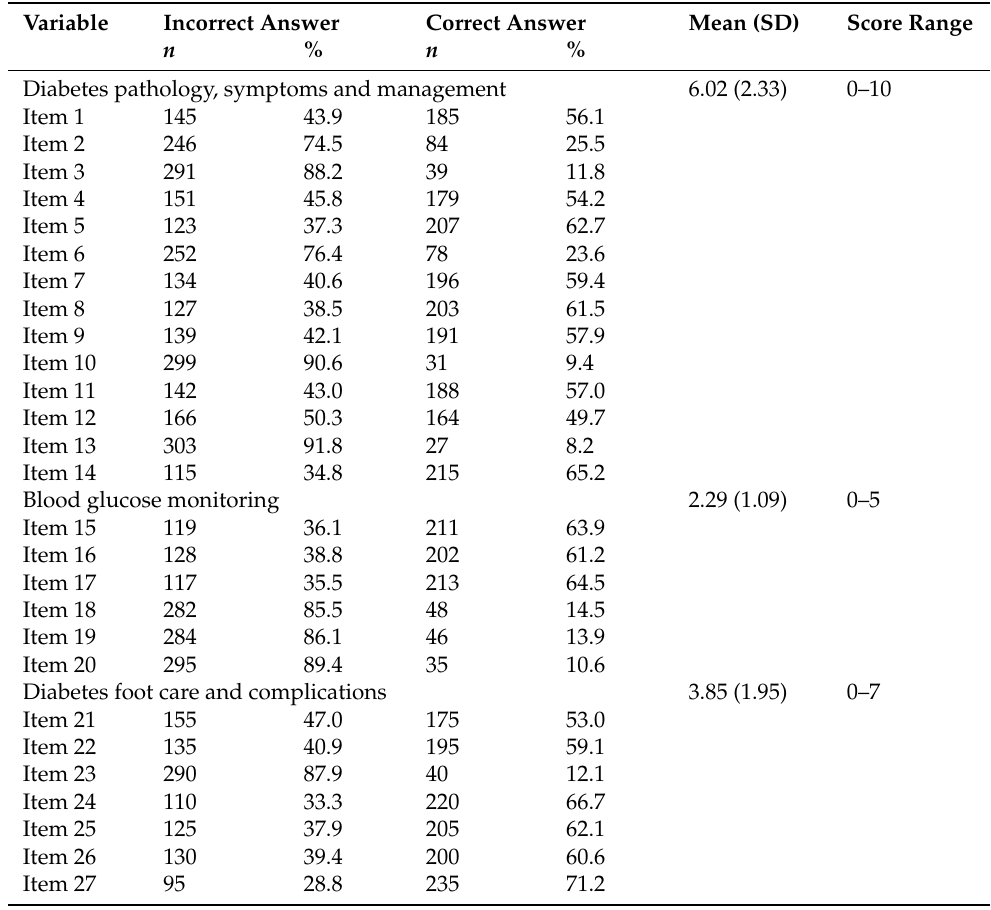
Table 4. Results of the descriptive analyses of actual diabetes knowledge ( n =